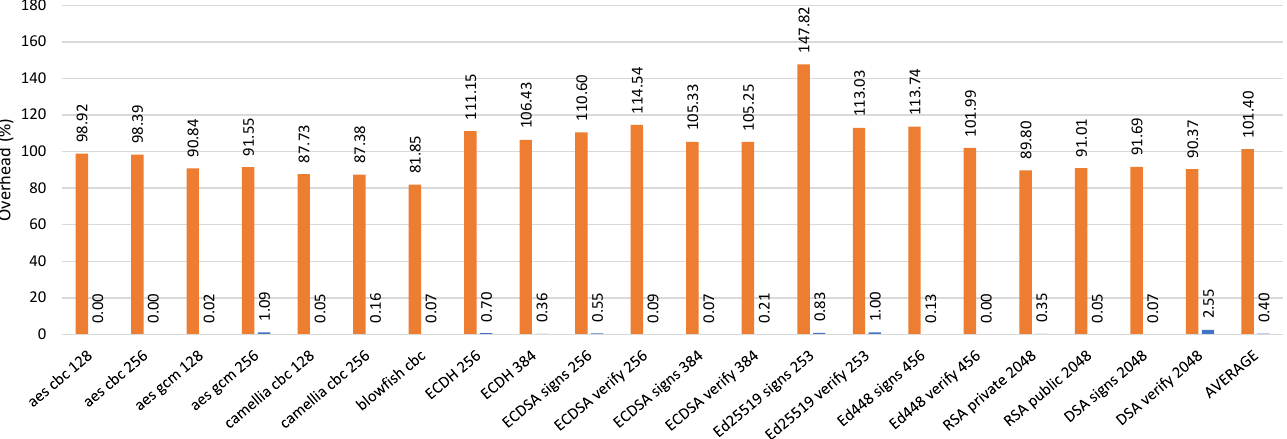
Figure 9. Execution time overhead for the in-process isolation with CoMeT and